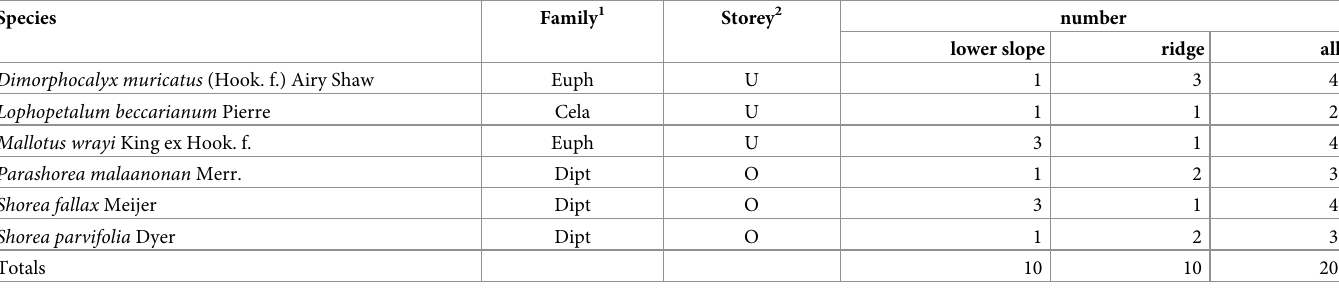
series. In October 2010 two stations were attacked by elephants, which resulted in severe dam- age to loggers and sensors so that the study had to be terminated by December 2011.